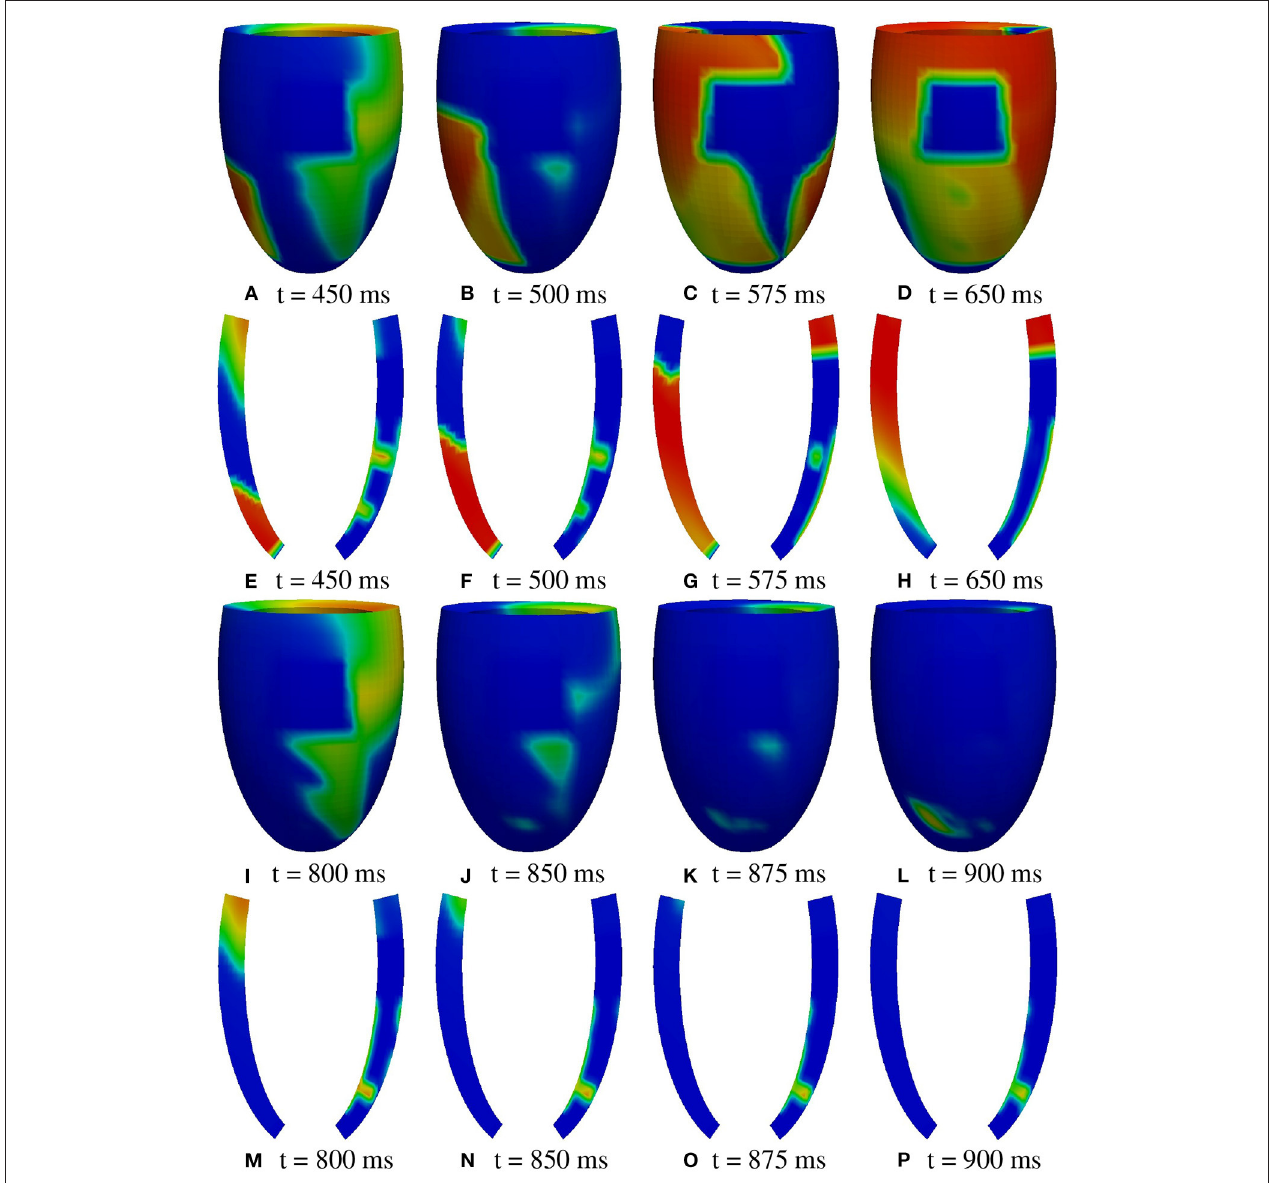
FIGURE 7 | Patient #1. A2 stimulation. (A–P) Transmembrane potential snapshots (t = 450–900 ms) on the epicardial surface and on a transmural section. t = 0 corresponds to the S1 stimulus. The S2 stimulus is applied at t = 350 ms. The colorbar is the same as in Figure 5